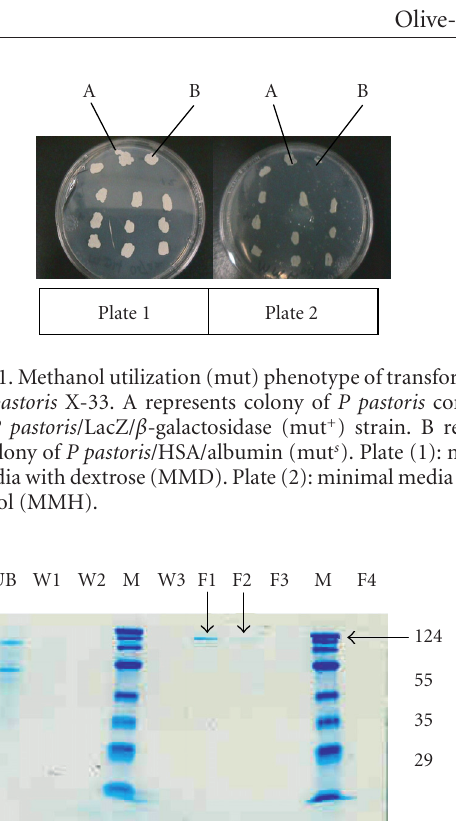
Figure 2. SDS PAGE gel of purified fractions of β -galactosidase expressed by P pastoris GS115/LacZ/mut + expression control cells, eluted from a ffi nity column. M represents molecular weight marker; UB represents unbound fraction. W1–W3 rep- resent wash fractions; F1–F4 represent eluted fractions. Purified recombinant β -galactosidase eluted in fraction 1 (F1) is indi- cated by band at approximate 124 kd.